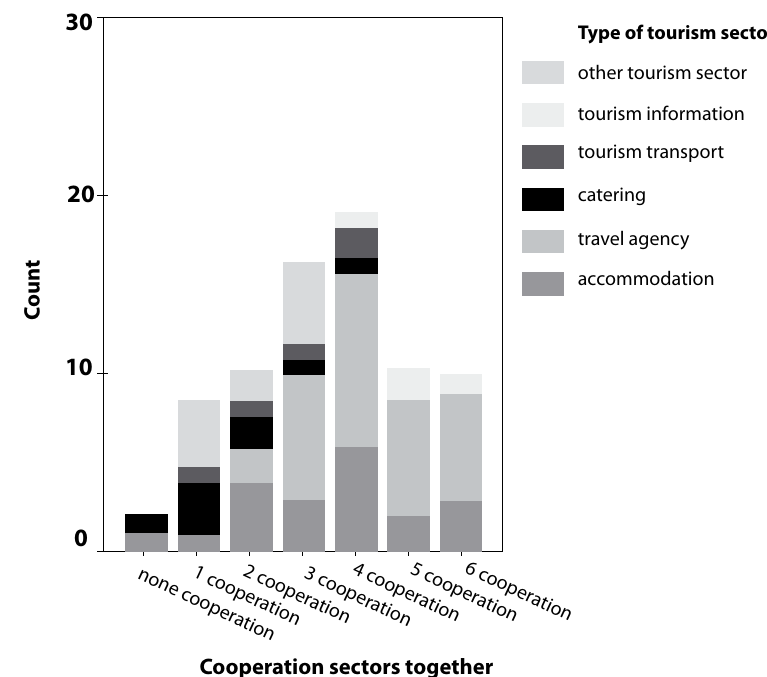
Fig. 4. Number of the cooperation sectors divided by Latvian tourism enterprise type,